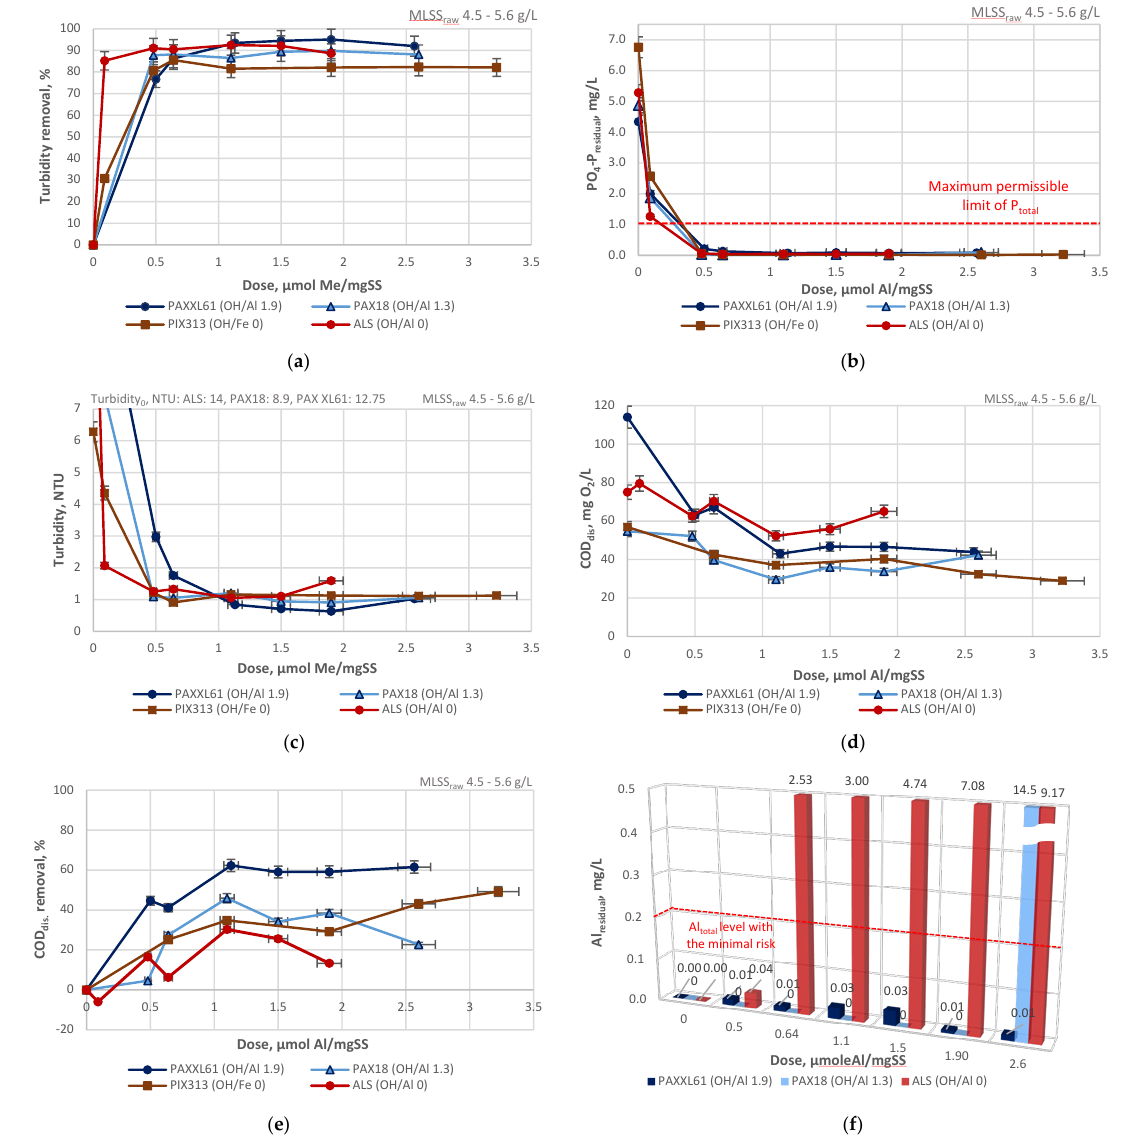
Figure 7. Influence of the coagulant dose on the parameters of treatment efficiency at fixed pH during the total recycle test (TRT): ( a ) turbidity removal; ( b ) residual orthophosphates; ( c ) turbidity, ( d ) dissolved COD (COD dis ); ( e ) COD dis removal; ( f ) residual aluminium.